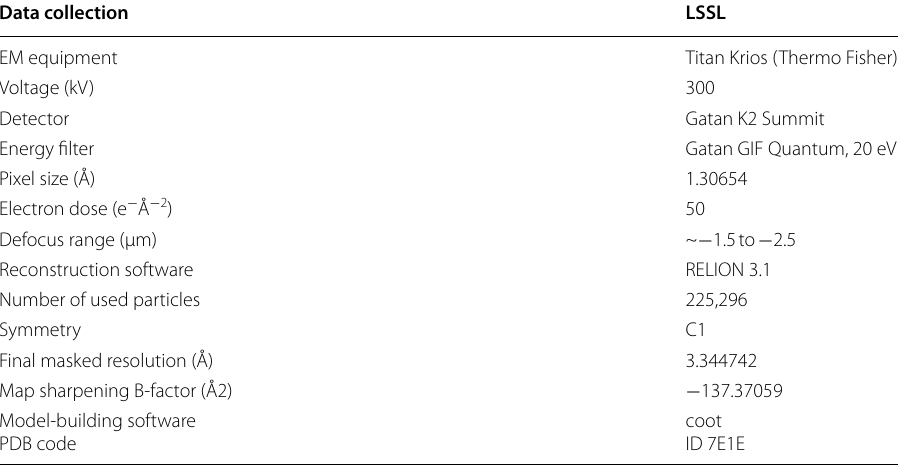
Table 1 Data collection and refinement statistics for